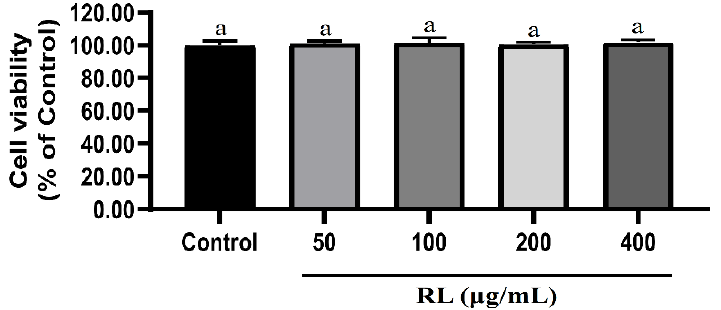
Figure 2. Effects of RL at various concentrations on cell viabilities of 3T3-L1 preadipocytes. Values presented as mean ± SD of experiments ( n = 3). Control—undifferentiated induced 3T3-L1 preadipocytes; RL—red ginseng and licorice extracts mixed at a 3:1 mass ratio. In Duncan’s multiple range test, p < 0.05 expressed in different lowercase letters and p > 0.05 expressed in same lowercase letters.